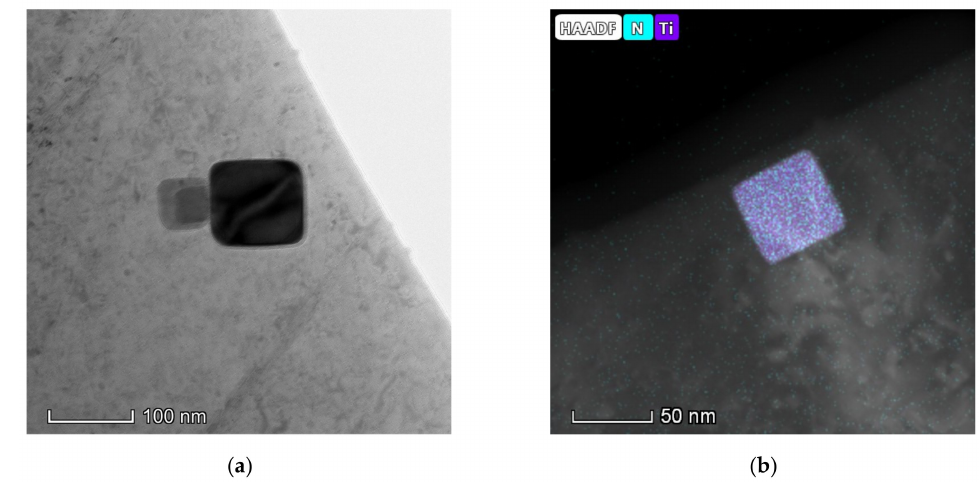
Figure 19. ( a ) TEM BF image of Ti-rich cuboidal precipitates in 100 dpa material; ( b ) composition map showing that in some cases they could be TiN.